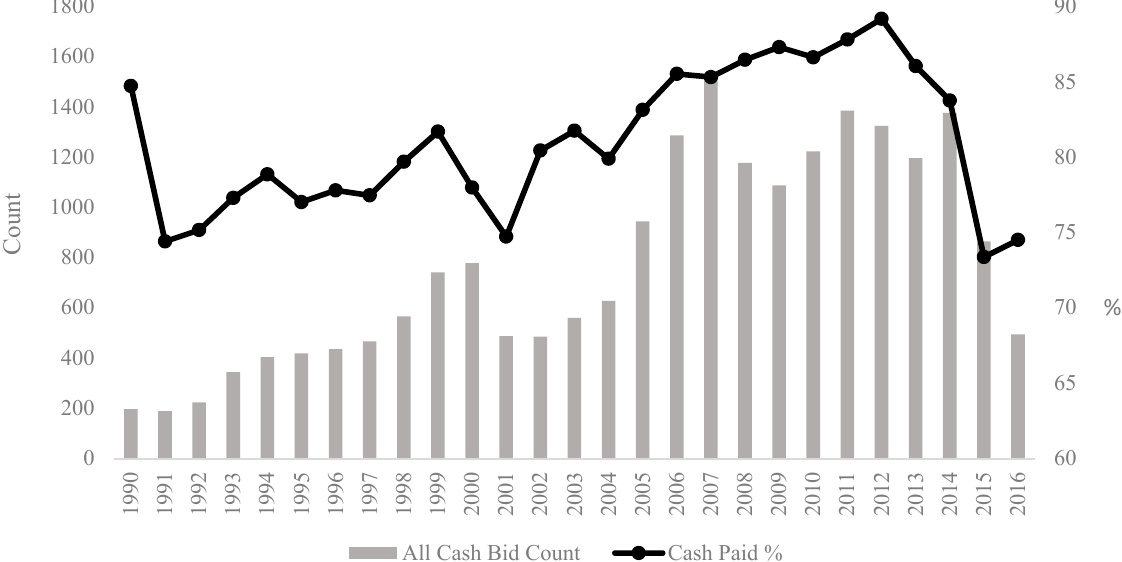
Figure 3. Bar and line chart showing the trend in cash paid for M&A transactions globally between 1990 and 2016. The bar chart (left) shows the number of all cash bids per year. The line chart (right) shows the mean percentage of cash paid in transactions.